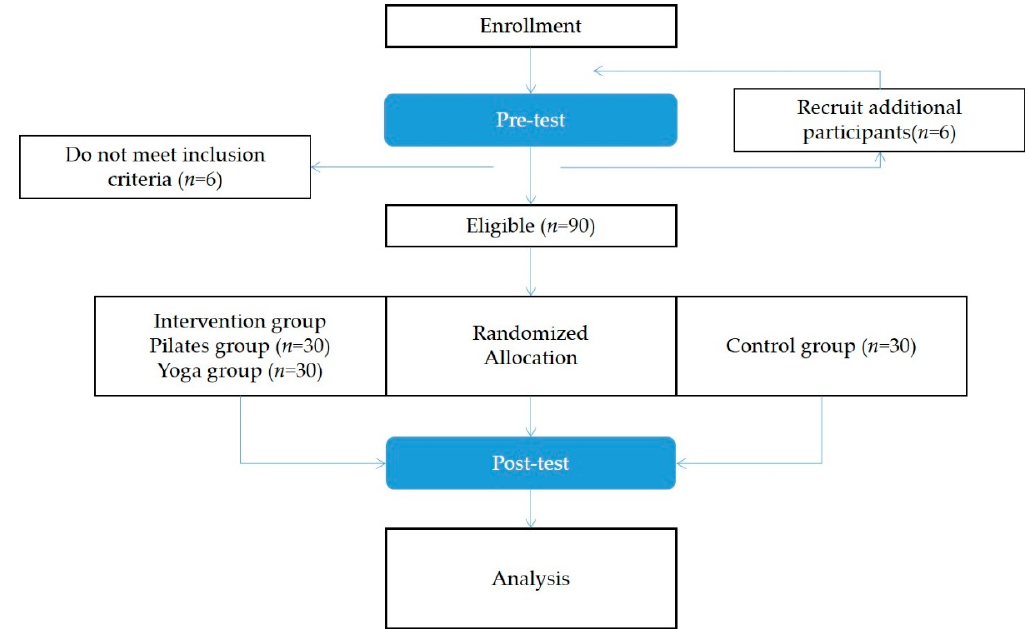
Figure 1. Research procedure.